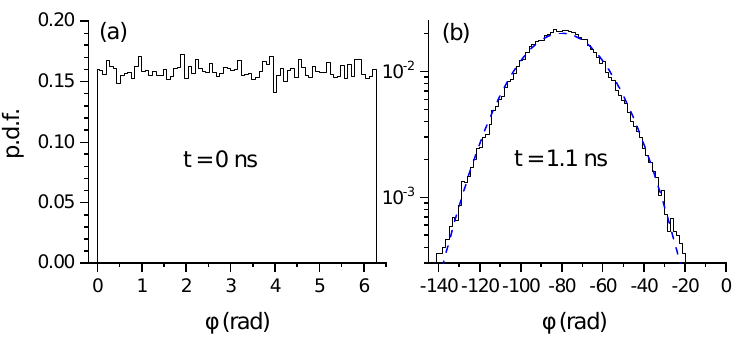
Figure 8. Probability density function of the phase at ( a ) t = 0 ns, and ( b ) t = 1.1 ns for a two-period window with T = 1 ns. The Gaussian approximation is plotted with a blue dashed